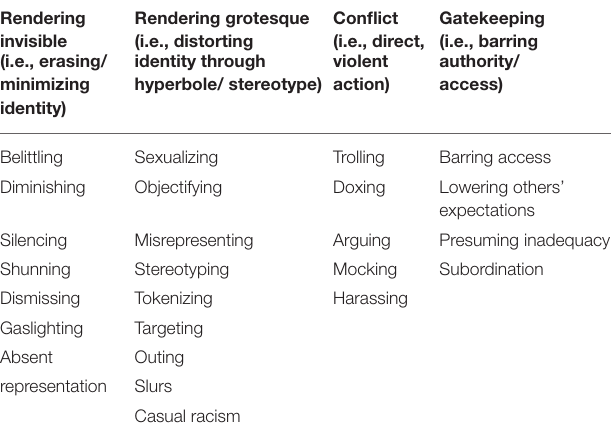
TABLE 1 | Four superordinate themes for discriminatory acts, with subthemes for each. Rendering